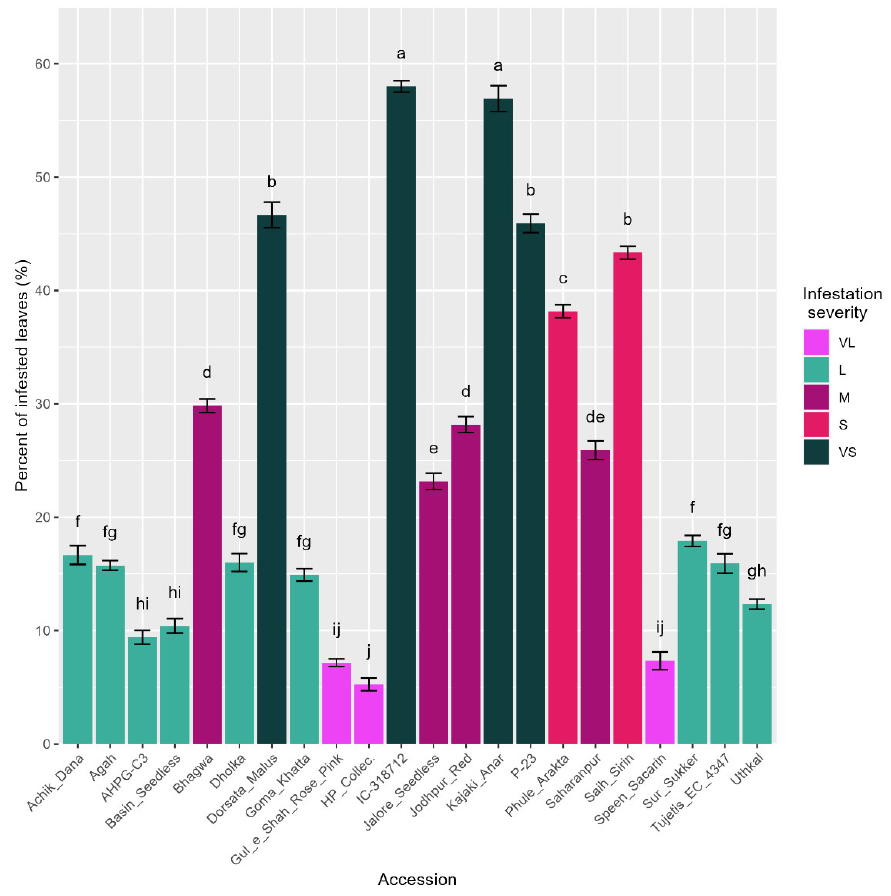
Figure 2. Percent of infested leaves measured in 22 pomegranate accessions ( n = 50). Different colors indicate the infestation severity class according to the color scale on the right-hand side. Bars with a common letter indicate that differences between accessions are not significant according to the Tukey test ( p ≤ 0.05).